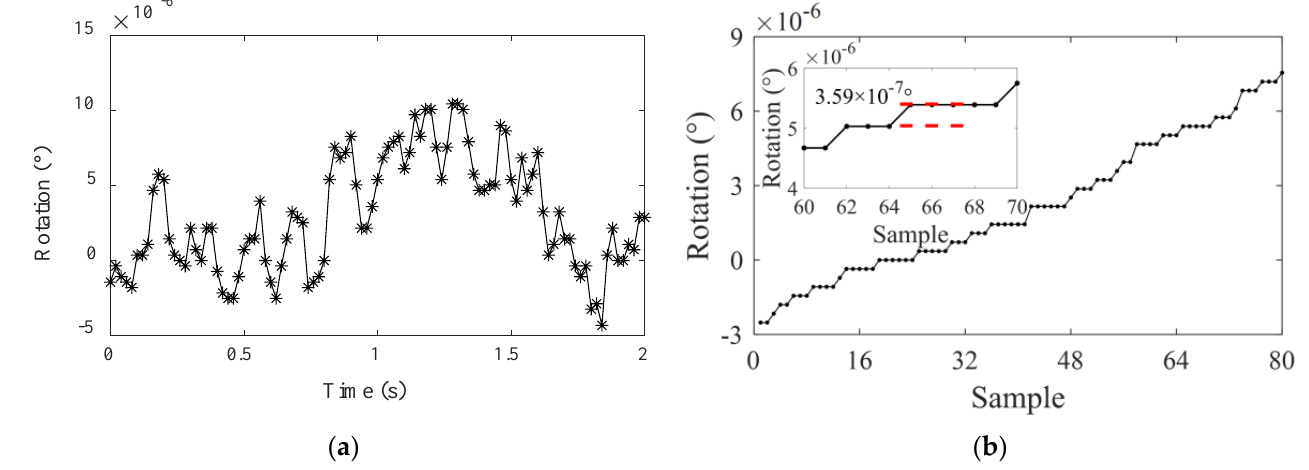
Figure 9. Resolution test chart ( a ) actual test curve; ( b ) resolution.